Question: From the figure, is the trend upward or downward?
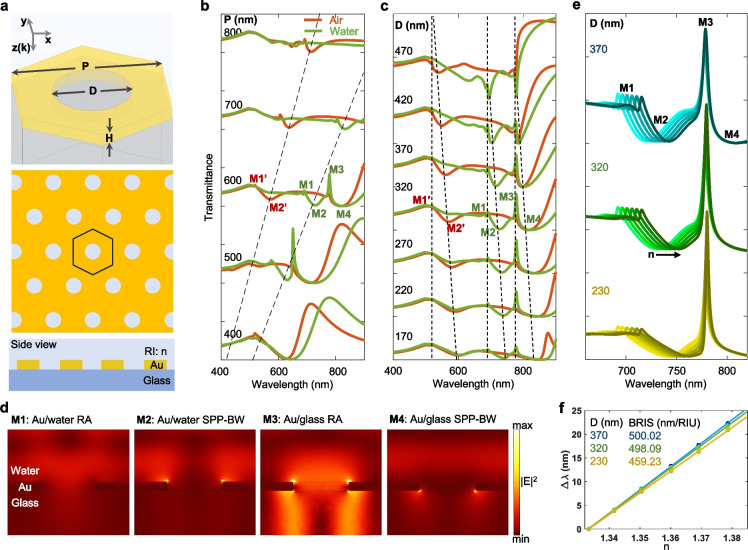
Answer: increasing